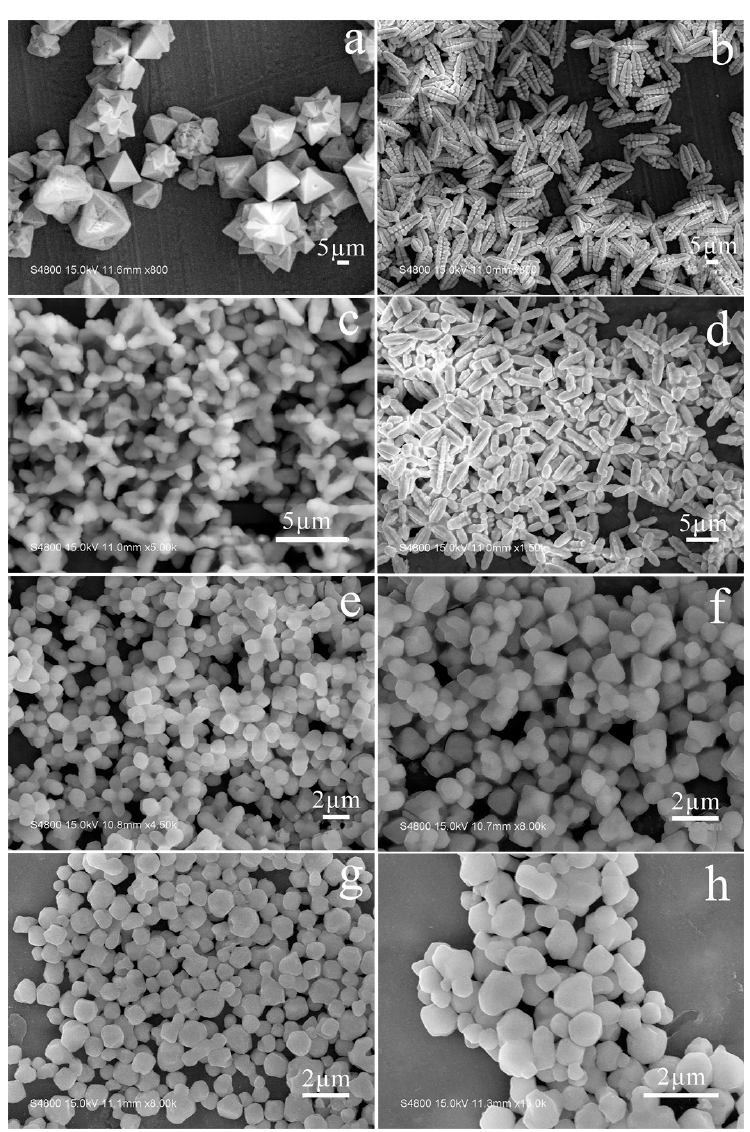
Figure 3. The SEM images of the Cs 2 SnCl 6 crystals prepared by ( a ) 3 mol/L, ( b ) 4 mol/L, ( c ) 5 mol/L, ( d ) 6 mol/L, ( e ) 7 mol/L, ( f ) 8 mol/L, ( g ) 9 mol/L, ( h ) 10 mol/L HCl for 0.083 mol/L SnCl 2 .